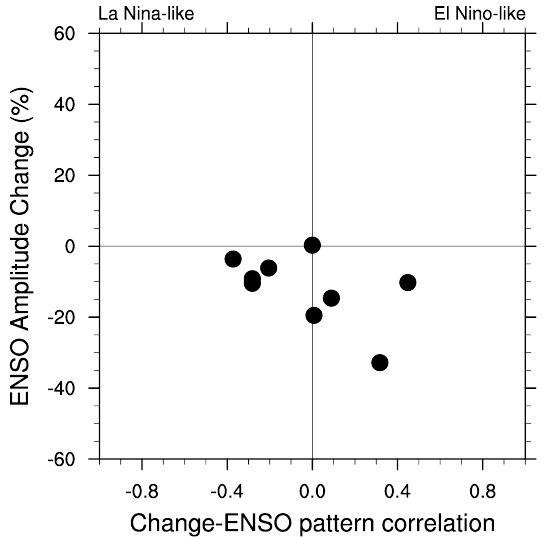
Figure 8. A scatter plot of the change in ENSO amplitude (from Fig. 1) to the correlation of Pliocene mean state changes projected onto the model’s leading tropical Pacific EOF.